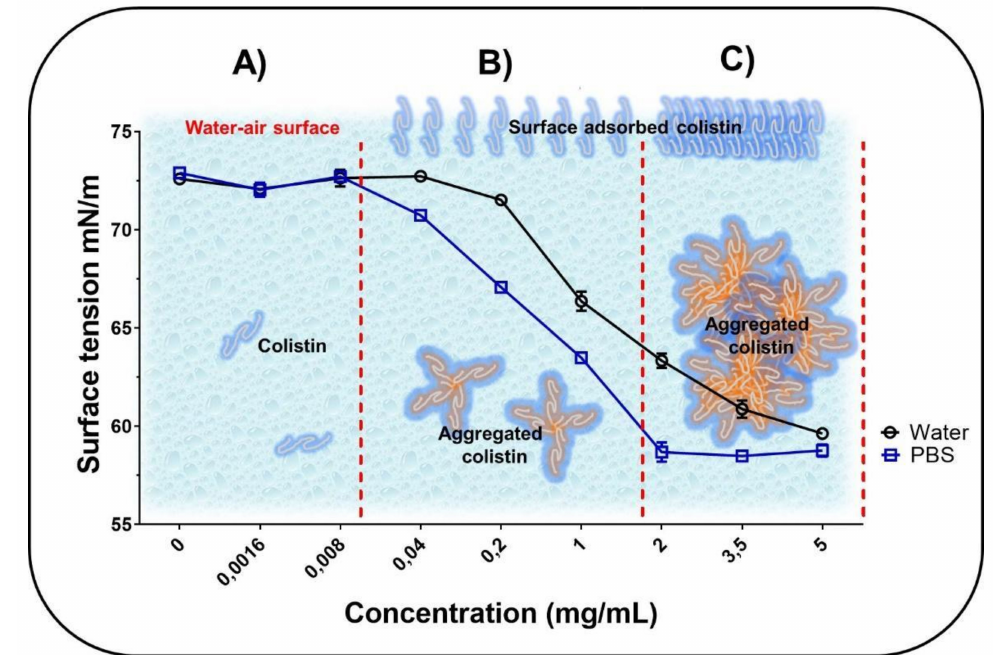
Figure 1. Characterization of the surface tension of Colistin (CST) in aqueous medium at different concentrations ranging from 0 to 0.008 mg/mL ( A ), from 0.008 to 2 mg/mL ( B ) and from 2 to 5 mg/mL ( C